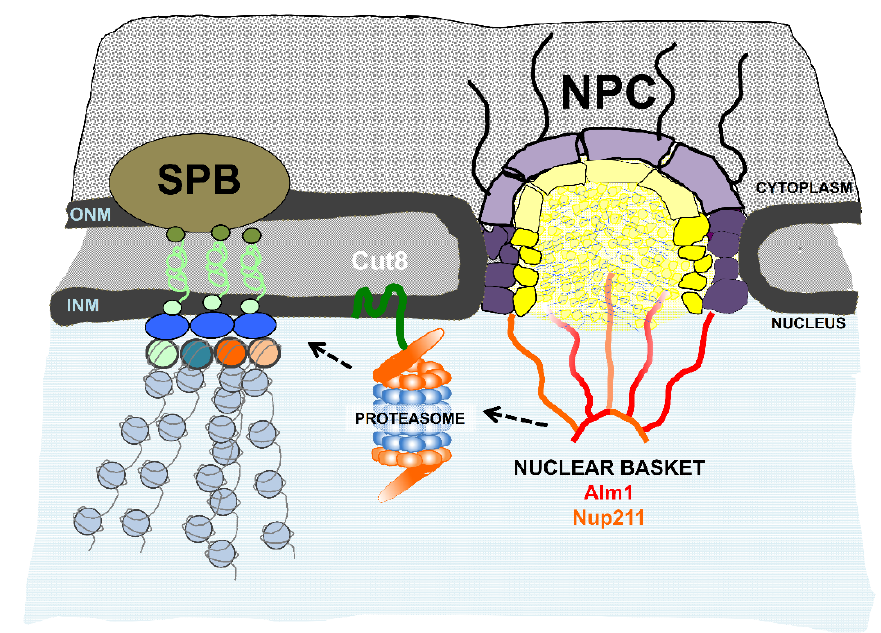
FIGURE 1: Schematic representa- tion of NPC, Centro- mere/Kinetochore clustering and proteasome localization to the NE. Working model. The fission yeast nuclear basket component Alm1 is required for proper localization of the pro- teasome and its anchor Cut8 to the NE. Deregulation/delocalization of proteasome from the NE results in unbalanced kinetochore compo- sition, which leads to chromosome